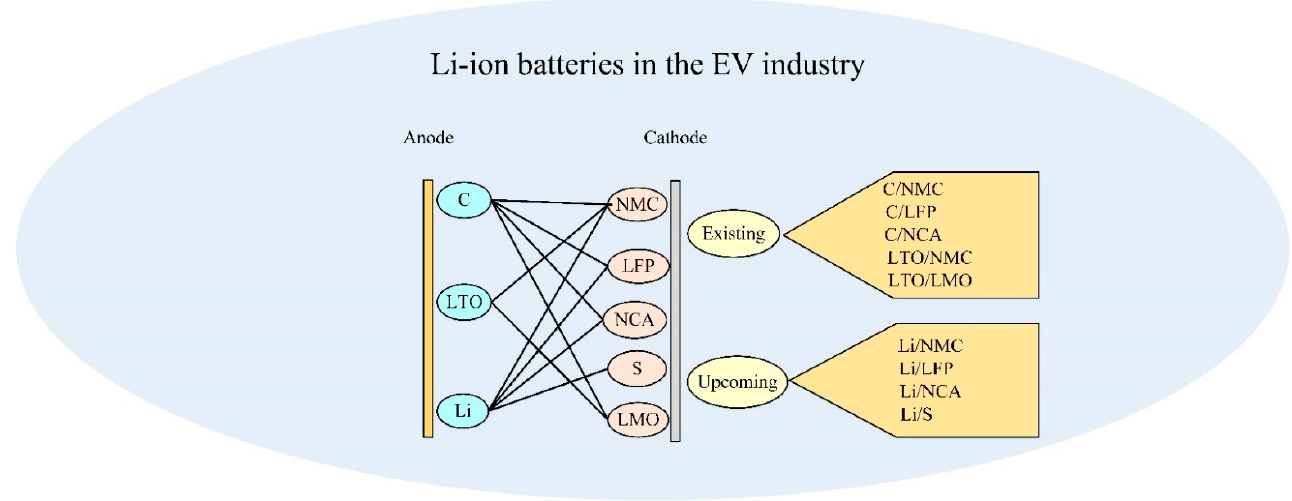
Figure 1. Li-ion batteries in the automotive industry.